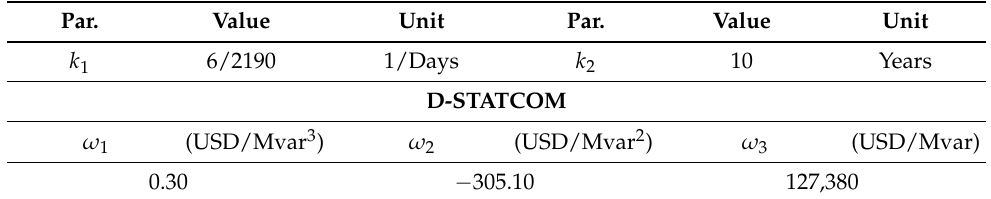
Table 7. Parametrization of the objective function for evaluating the location of D-STATCOMs in distribution